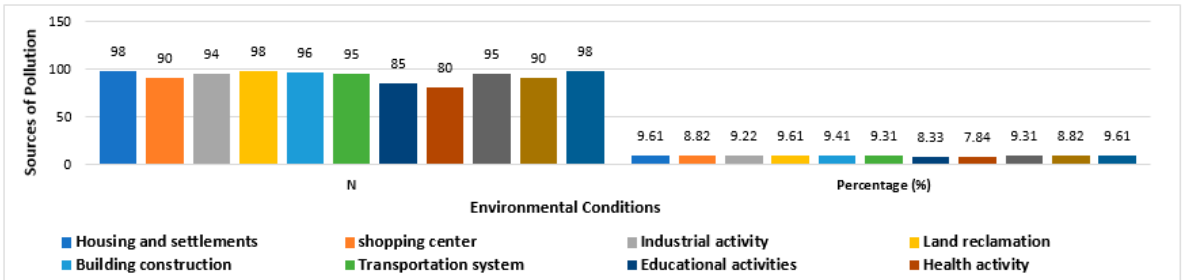
Figure 5. Decreasing environmental quality in Makassar City. Source: Primary data.